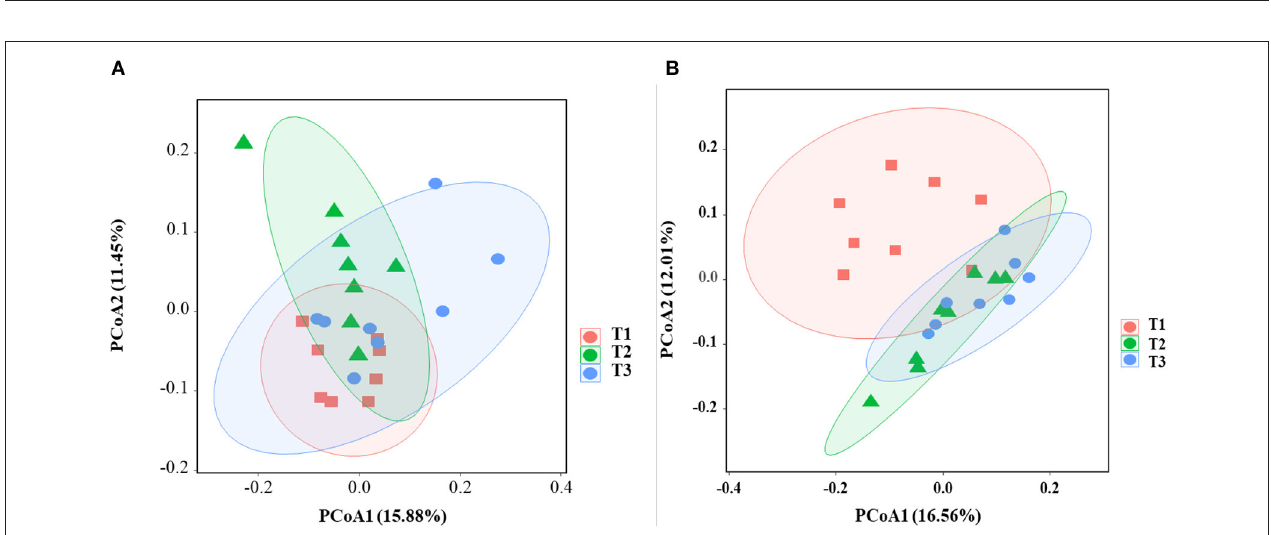
FIGURE 4 | Effects of dietary amylose/amylopectin ratio on beta-diversity in the cecal mucosa (A) and digesta (B) . The PCoA plot was generated using unweighted UniFrac-based. T1 (normal corn 100%, high amylose corn 0%); T2 (normal corn 50%, high amylose corn 50%); T3 (normal corn 0%, high amylose corn